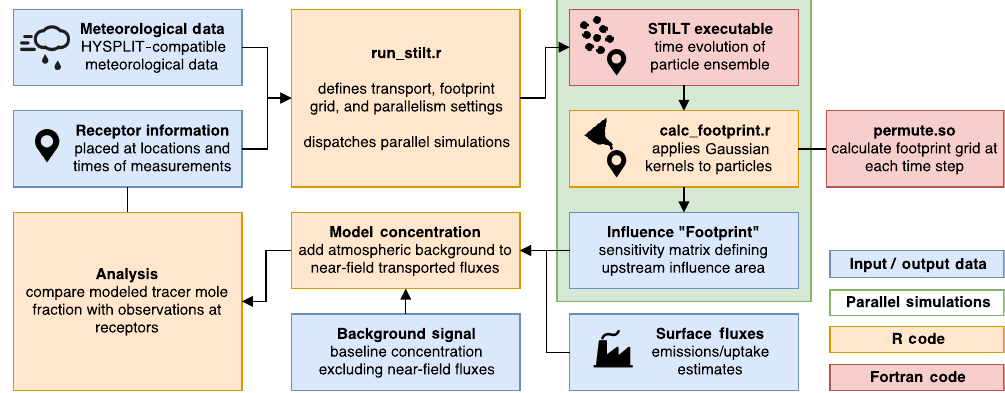
Figure 1. STILT workflow to model tracer mole fraction at a receptor. STILT advects particles and calculates the influence footprint for each receptor. Footprints are convolved with surface fluxes and an atmospheric background signal to model the tracer mole